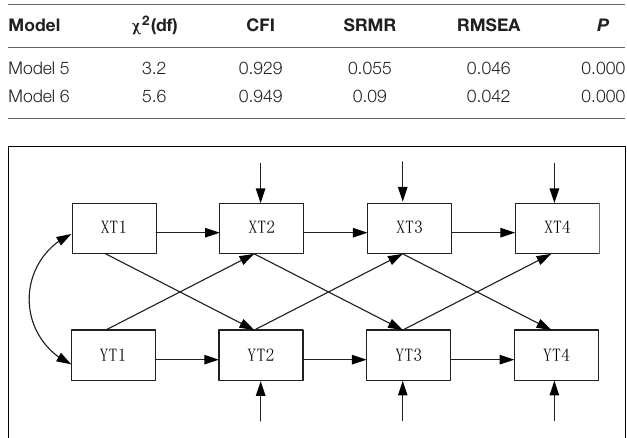
FIGURE 10 | Cross-lagged regression